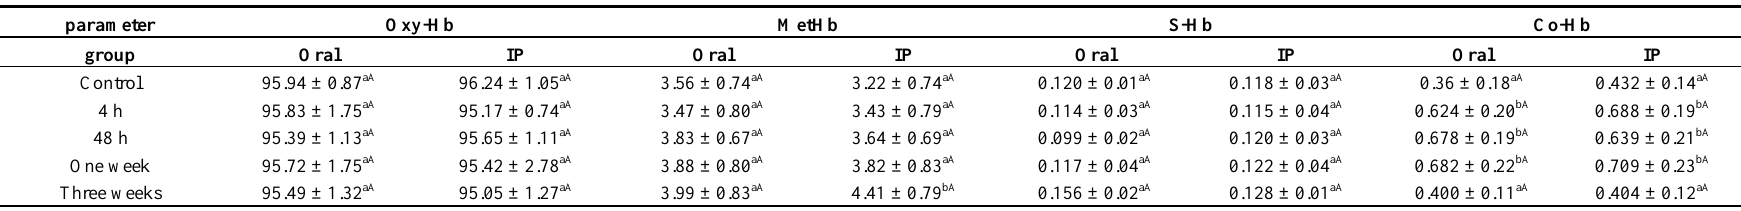
Table 3. The effect of oral administration and i.p. injection of ENPs on Hb derivatives (expressed as percent of total hemoglobin) in rats.